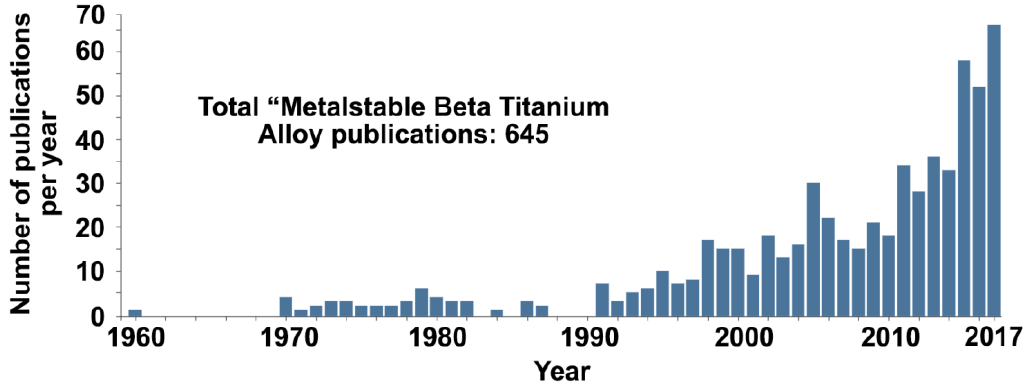
Figure 19. History of number of publications on “Metastable beta titanium alloy” from Web of Science.